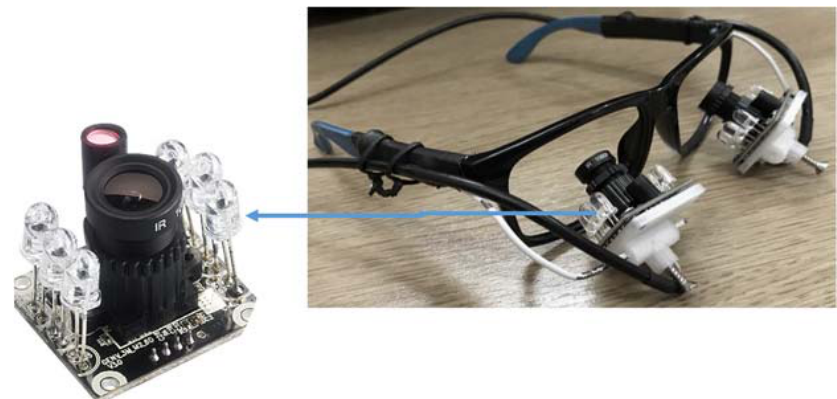
Figure 5. Image acquisition system using IR camera.